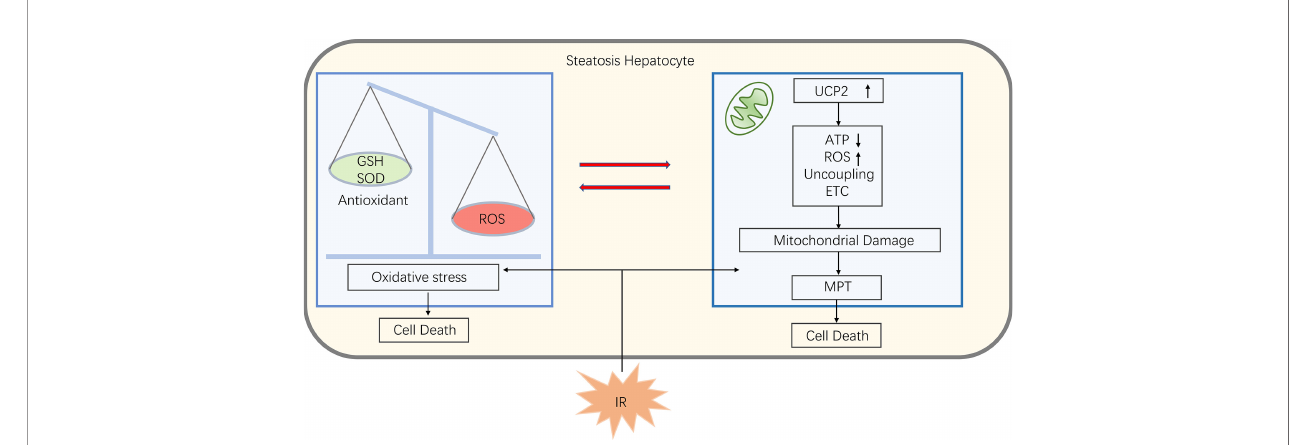
FIGURE 4 | In steatosis hepatocyte, an imbalance of ROS and antioxidants leads to oxidative stress that damages mitochondria. Also oxidative stress promotes uncoupling protein 2 (UCP2) expression, which can uncouple electron transport chains (ETC), thereby reducing ATP synthesis and induce ROS production, further promoting oxidative stress. When fatty liver encounter IR, the mitochondria at this statute are more susceptible to mitochondrial permeability transitions (MPT), leading to cell death.